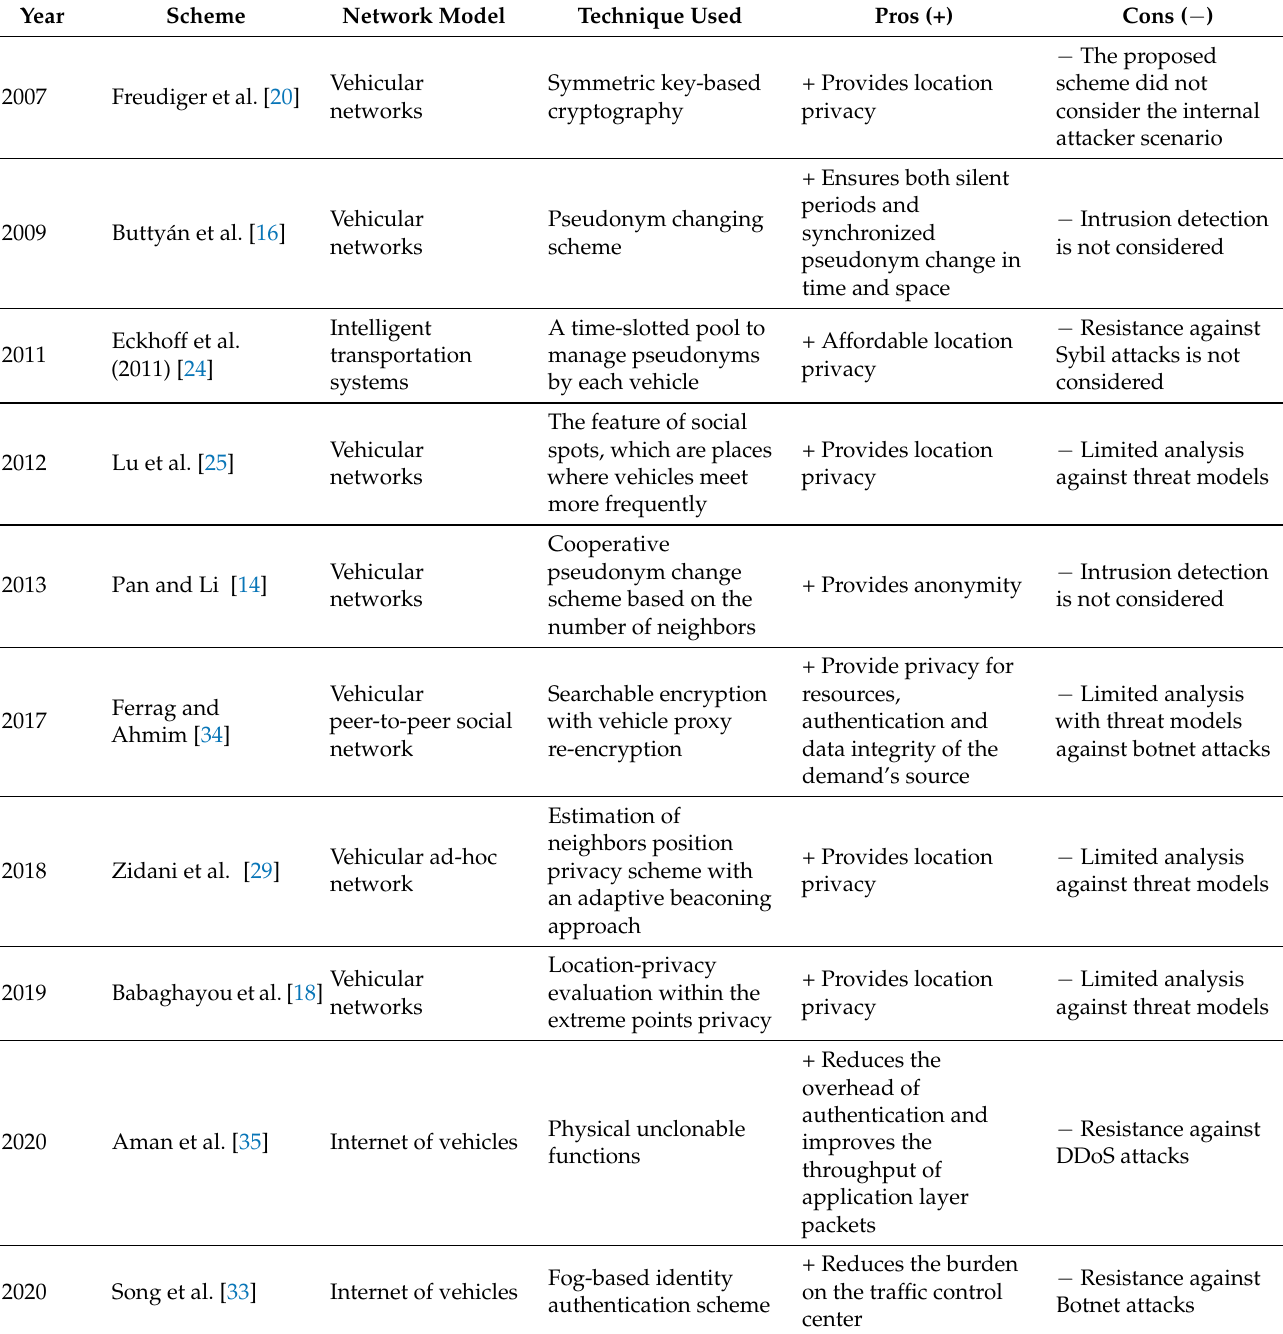
Table 1. Comparison of related